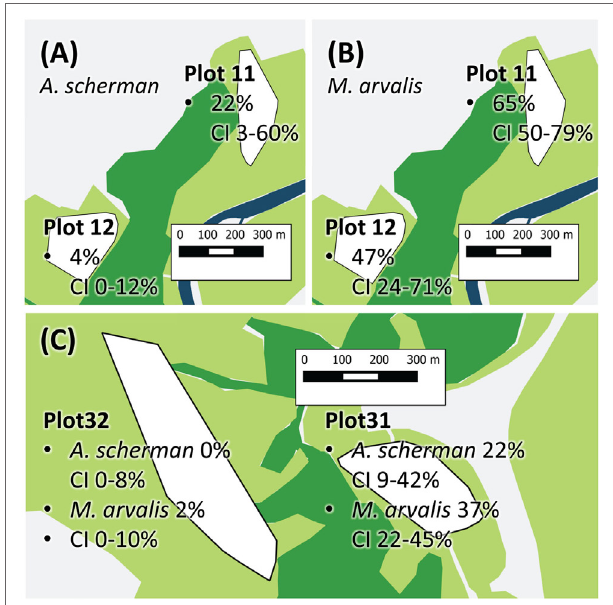
FigUre 2 | Exemplary prevalence rates of Plot 11 and 12 show Arvicola scherman (a) and Microtus arvalis (b) prevalences from spring 2014. On plot 12, the prevalence of M. arvalis is significantly higher compared to the prevalence of A. scherman . (c) The two vole populations of A. scherman and M. arvalis, are significant more frequently infected on plot 31 than on the nearby plot 32. The different colors represent forest (dark green), cultivated land (light green, mainly fields and pastures), and streets and village (light gray). The trapping plots for A. scherman and M. arvalis (white polygons) are situated in the cultivated